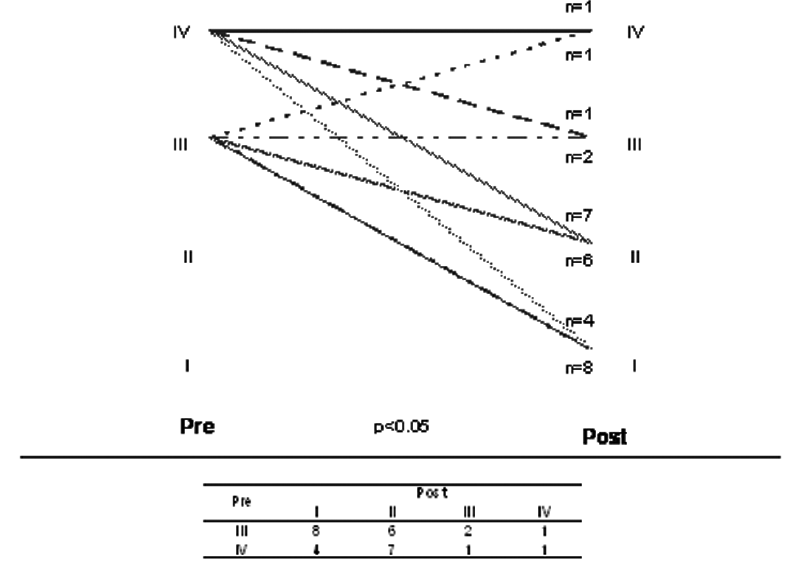
Figure 3 - The NYHA functional class improved to I in 40% and II in 43% of the patients postoperatively